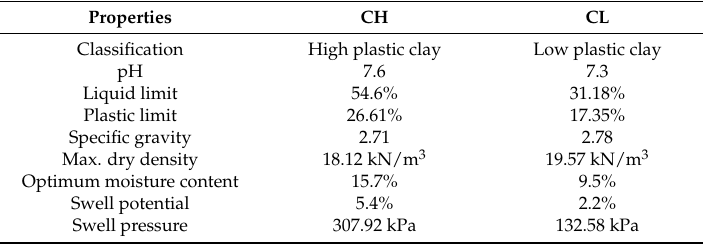
Table 1. Physical and chemical properties of soil